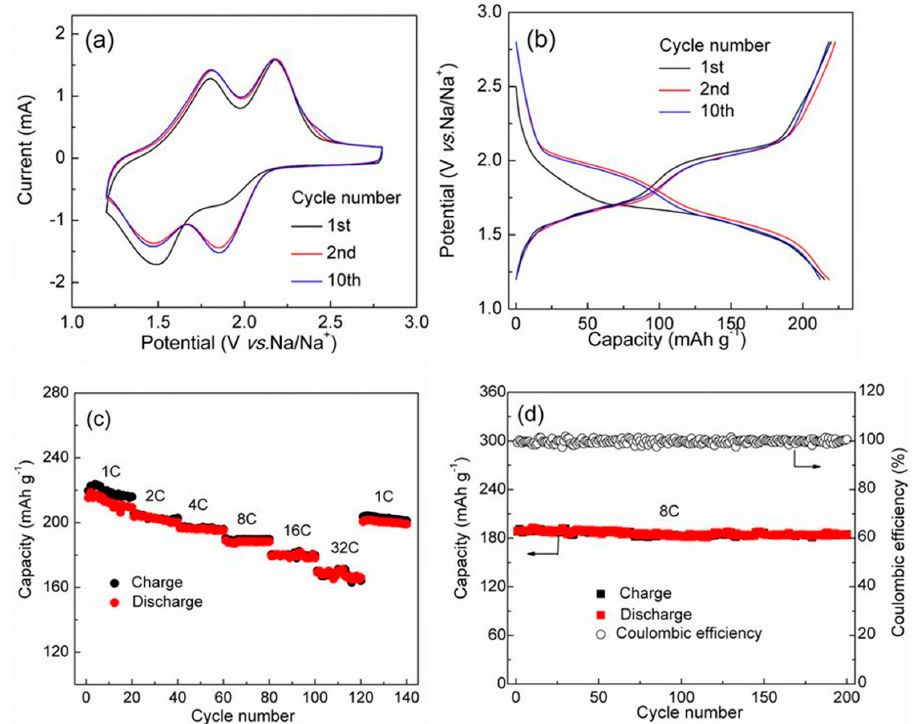
Figure 3. Electrochemical performance of polymer 15 as candidate anode material for sodium-ion batteries: ( a ) cyclic voltammograms (CV) curves at a scan rate of 5 mV · s − 1 ; ( b ) charge and discharge profiles at a current density of 180 mA · g − 1 ; ( c ) rate performance (1C = 200 mA · g − 1